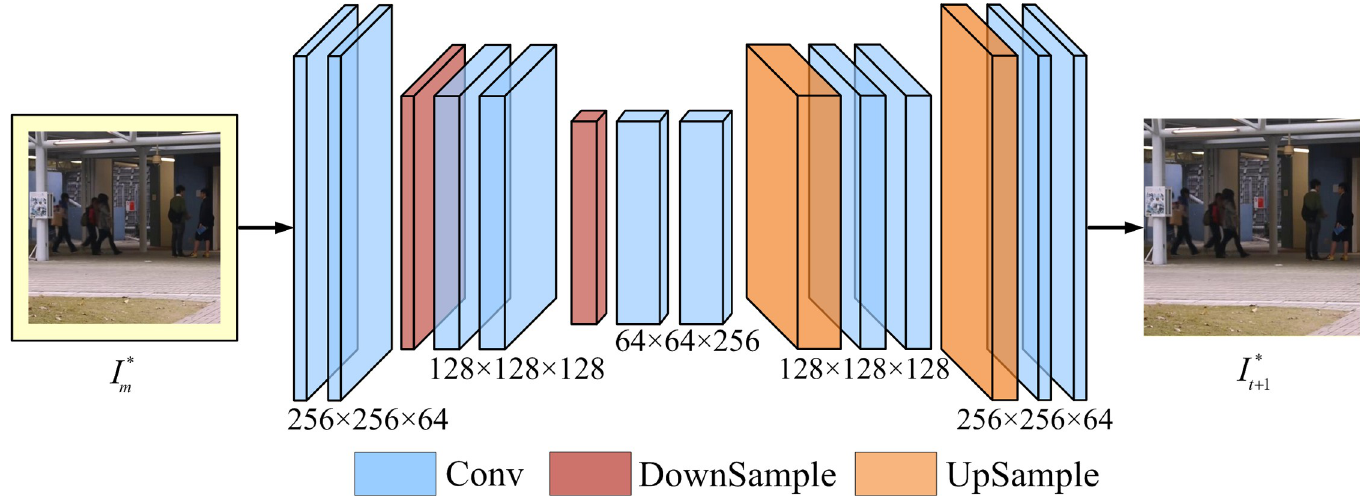
Fig 5. Structure of reconstruction module. The input and output size of the module are both 256 × 256 × 3. The kernel sizes of all convolution and deconvolution are set to 3 × 3 and the downsample layers are set to 2 × 2. The resolutions of feature maps are equal in the same convolution layer.